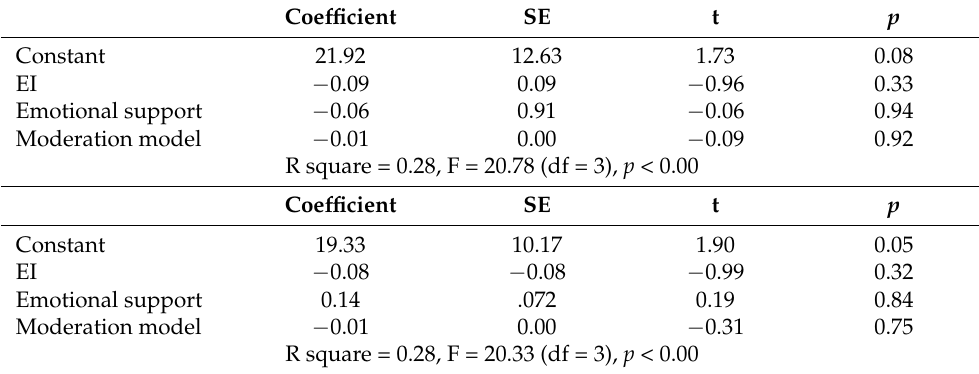
Table 2. A summary of PROCESS mediation analysis for social support (two separate measures) (n =